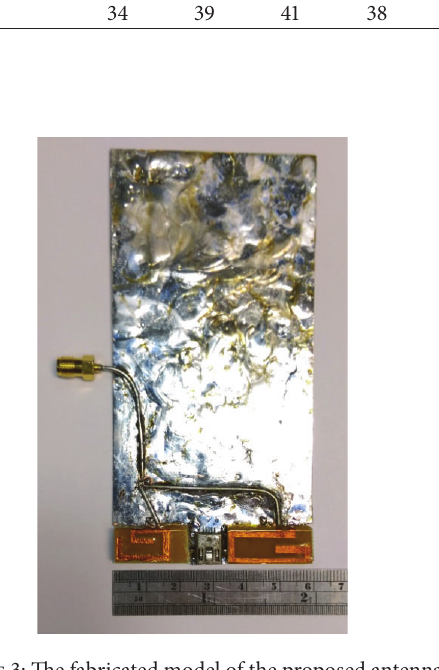
Figure 3: The fabricated model of the proposed antenna.